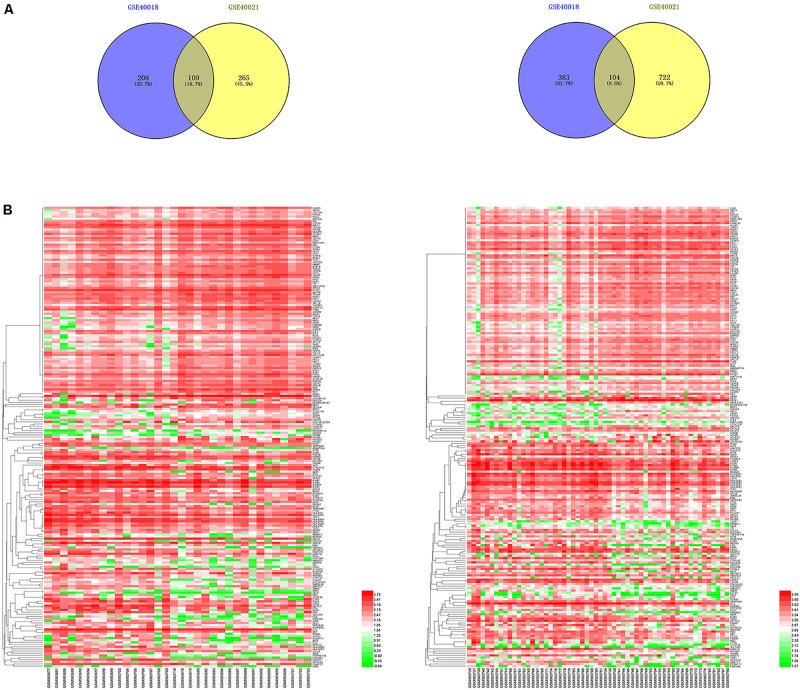
Identification of DEGs associated with SS metastasis. (A) Venn diagram demonstrates the crossed genes shared by GSE40018 and GSE40021 datasets. Left panel represents the upregulated co-differentially expressed genes between GSE40018 and GSE40021 datasets, whereas the right panel represents the downregulated intersectional genes between the two datasets. (B) Heatmap of the top 213 DEGs associated with SS metastasis in the two datasets. Left, GSE40018; right, GSE40021.